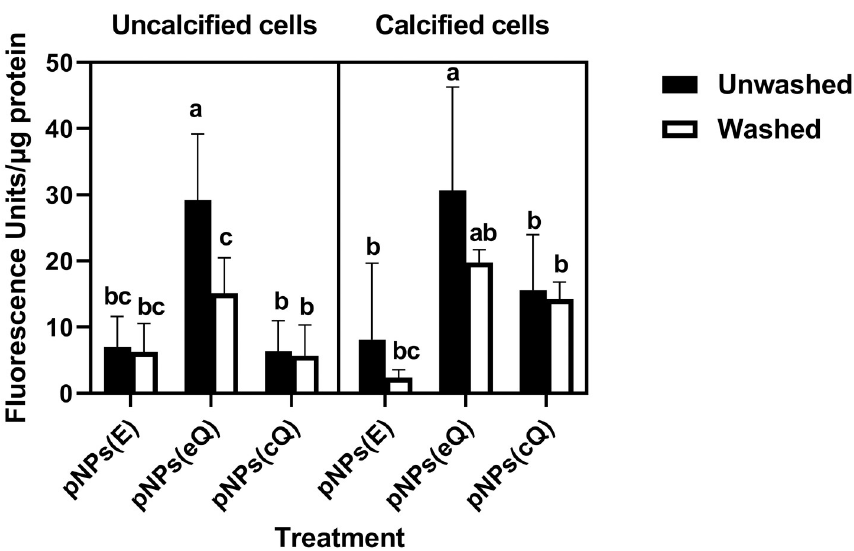
Fig 6. pNPs(cQ) exhibit a reduced ability to bind to rat aortic smooth muscle cells but their binding is resistant to washing and calcification. pNP suspensions at 2 mg/mL were allowed to bind to cells for 2 hours before washing with buffer. Some sets of cells were subjected to a calcification treatment prior to pNP exposure. Green fluorescence determined before and after washing was normalized to protein in the well. Data are means ± SD for n = 9. Three-way ANOVA revealed a significant effect of pNP treatment, calcification and washing. Means denoted by unlike letters represent significant differences for the same cell growth conditions, revealed using Bonferroni’s post-hoc tests.